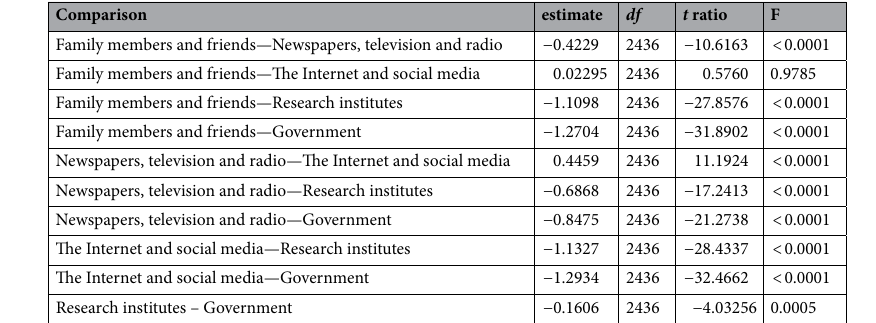
Table 4. Comparison of credibility of different information by Tukey’s